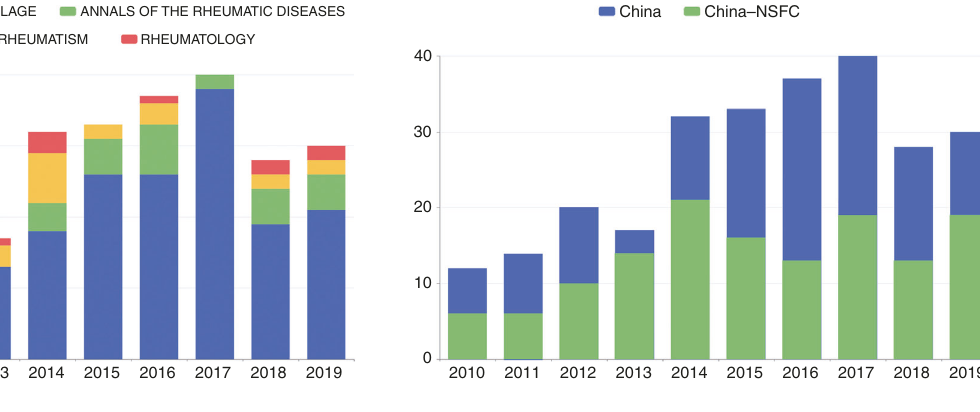
et al. showed that compared to other commonly used nonster- oidal anti-in fl ammatory drugs, tramadol might increase all-cause mortality in patients with OA. This research had a signi fi cant impact on domestic and international guidelines for the treatment of OA. 25 Ding C et al. showed that vitamin D supplementation has no obvious effect on the loss of tibial cartilage in patients with